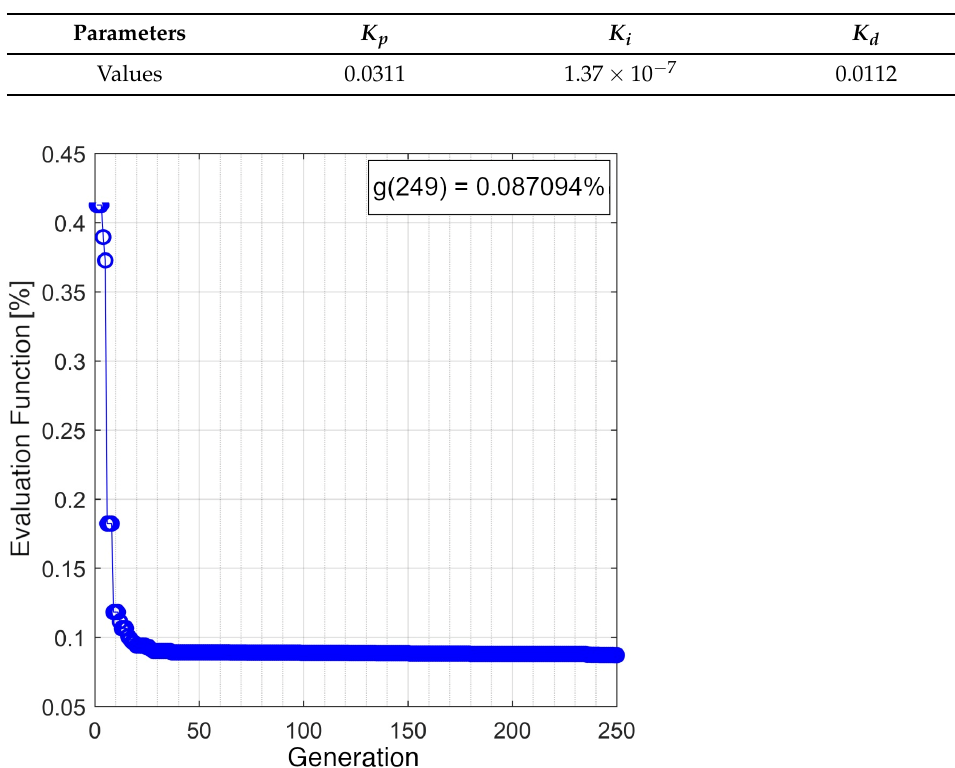
Table 3. Optimized parameters for tuning the PID controller.